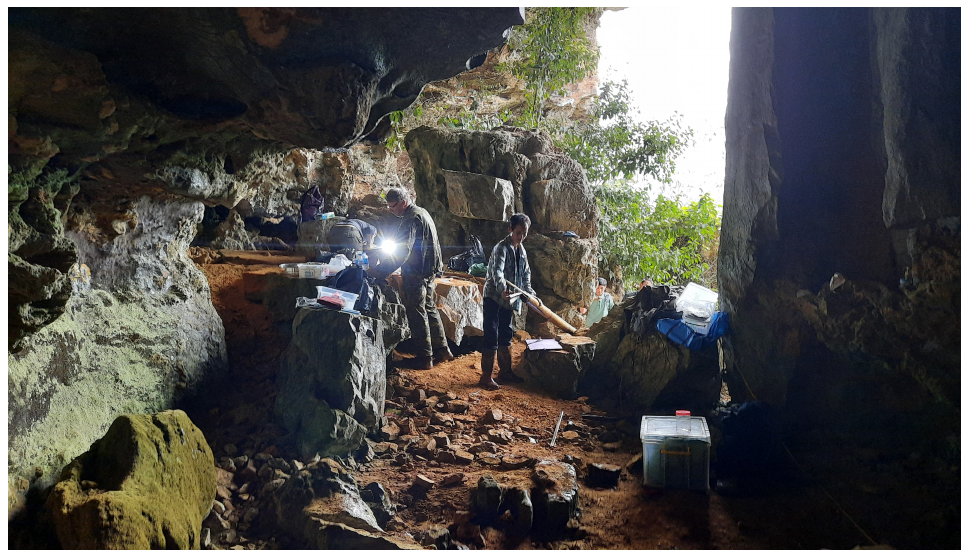
Figure 4. Excavations in Tham Hai Cave